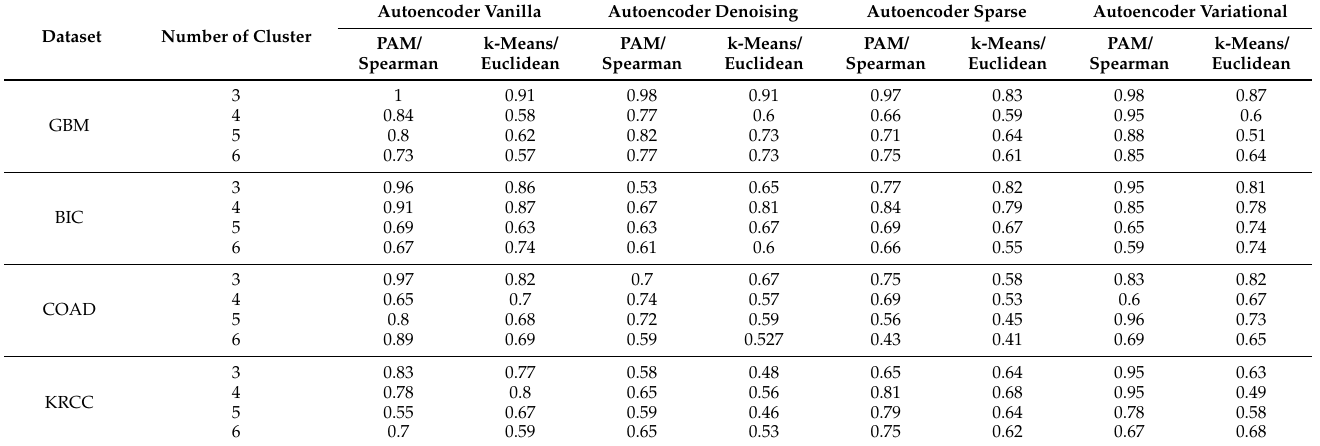
Table 2. Silhouette index results for the clusters generated with the autoencoder output.